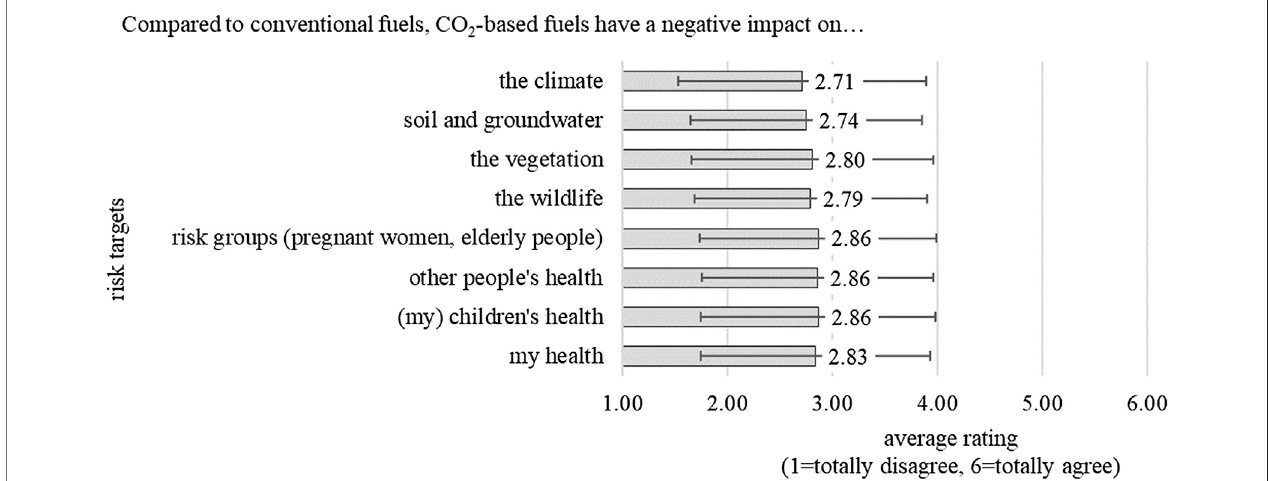
Frontiers in Energy Research |